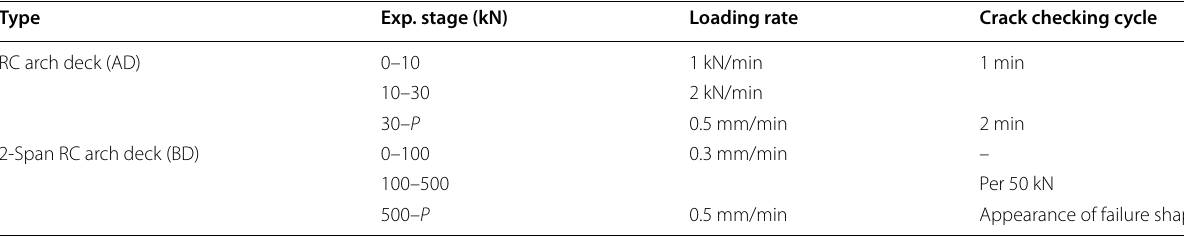
Table 2 Static loading test